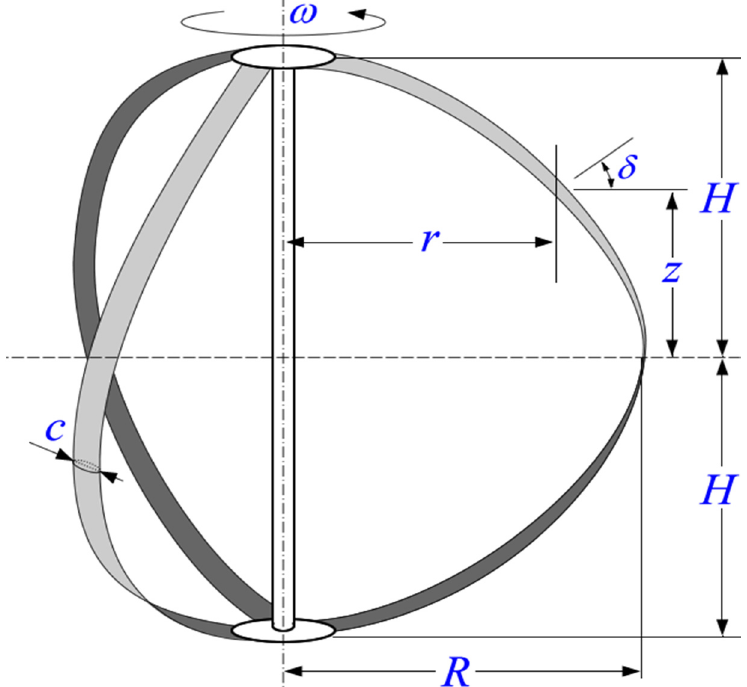
Figure 1. Curved, three-blade, Darrieus-type